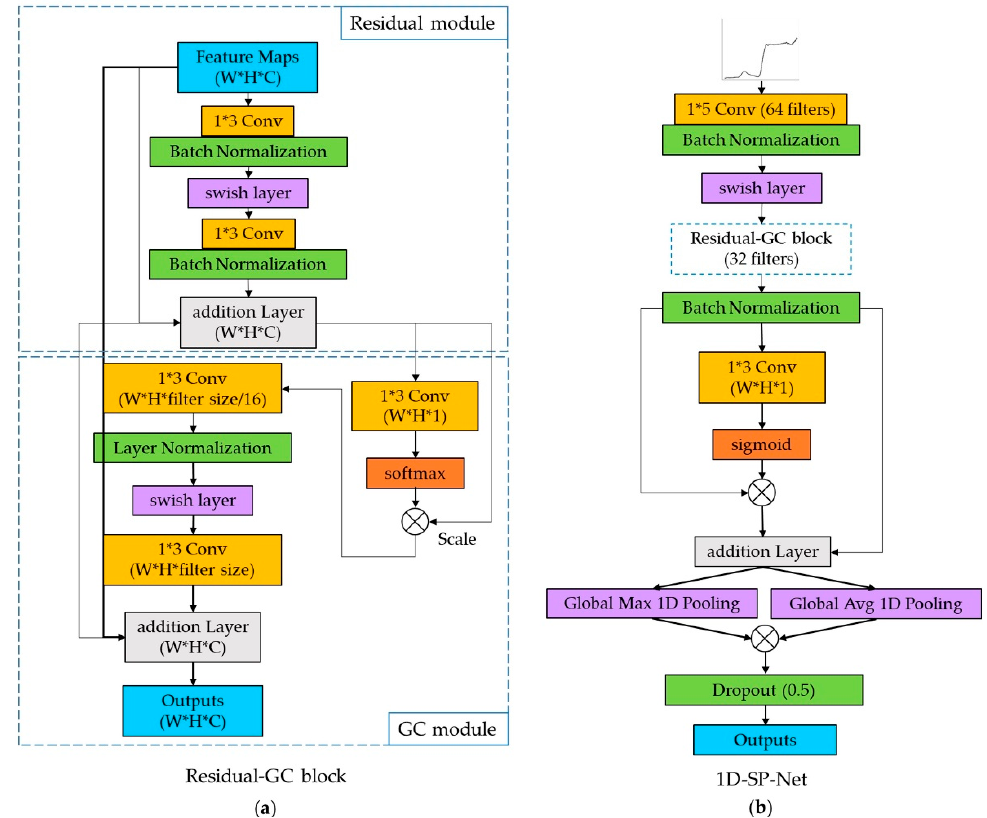
Figure 3. Architecture of the proposed 1D-SP-Net: ( a ) residual block and global context (GC) block; ( b ) hierarchical structure of the 1D-SP-Net.